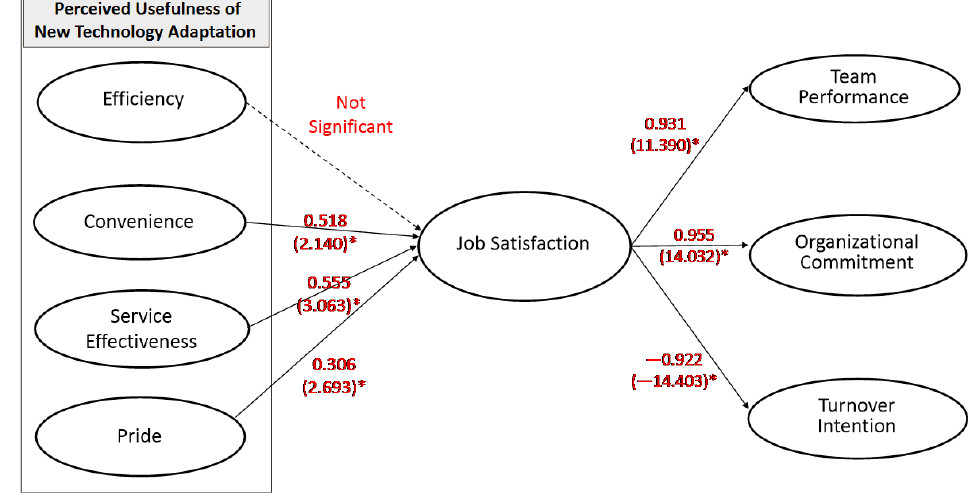
Figure 2. The Results of the Proposed Model (* p < 0.05).